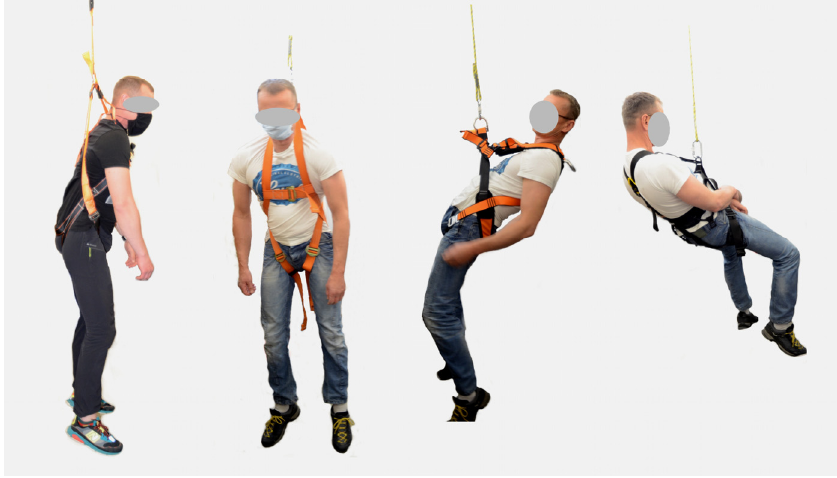
Figure 2. Sample images of human subjects suspended in safety harnesses.